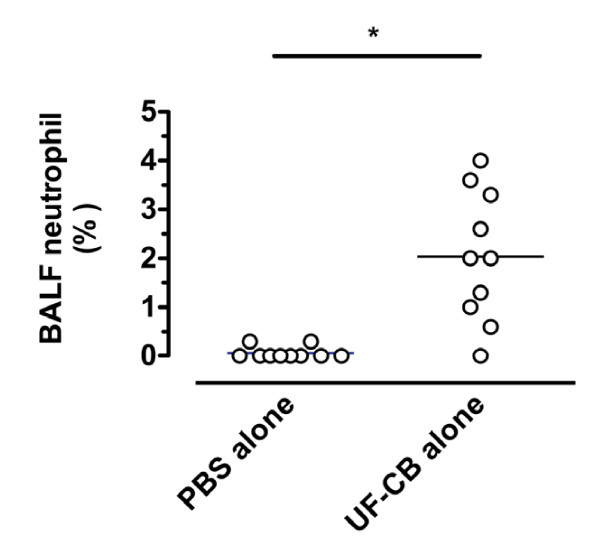
Neutrophil differential count in bronchoalveolar lavage fluid mice receiving either 2× doses on intranasal sterile PBS alone, or 2 doses of 500 μg ultrafine-carbon black in 50 μL PBS alone (UF-CB). BAL was done 72 h after the second intranasal dose. Each symbol represents an individual mouse. Bar represents mean, n = 10, *P < 0.01 by unpaired t test.